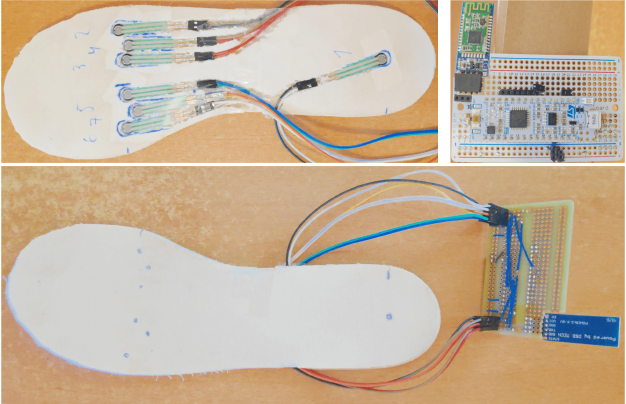
Figure 3. ( up-left ) Below of the instrumented insole, ( up-right ) Embedded system with connections, ( down ) Top view of the final system.